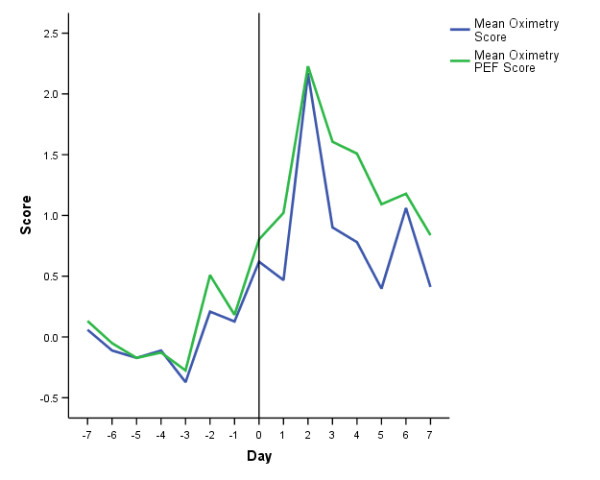
Time Course of Oximetry and Oximetry-PEF Scores At Exacerbation. Time course of Oximetry and Oximetry-PEF scores from seven days prior (-7) to exacerbation onset (day 0, vertical line) and seven days into exacerbation of COPD. Values are the mean score of 13 exacerbations in 13 patients (see text for details).